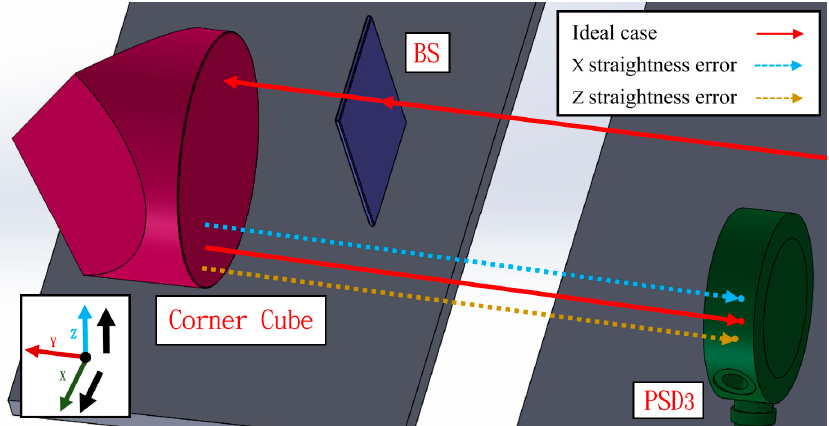
Figure 5. Light path with horizontal straightness error or vertical straightness error.